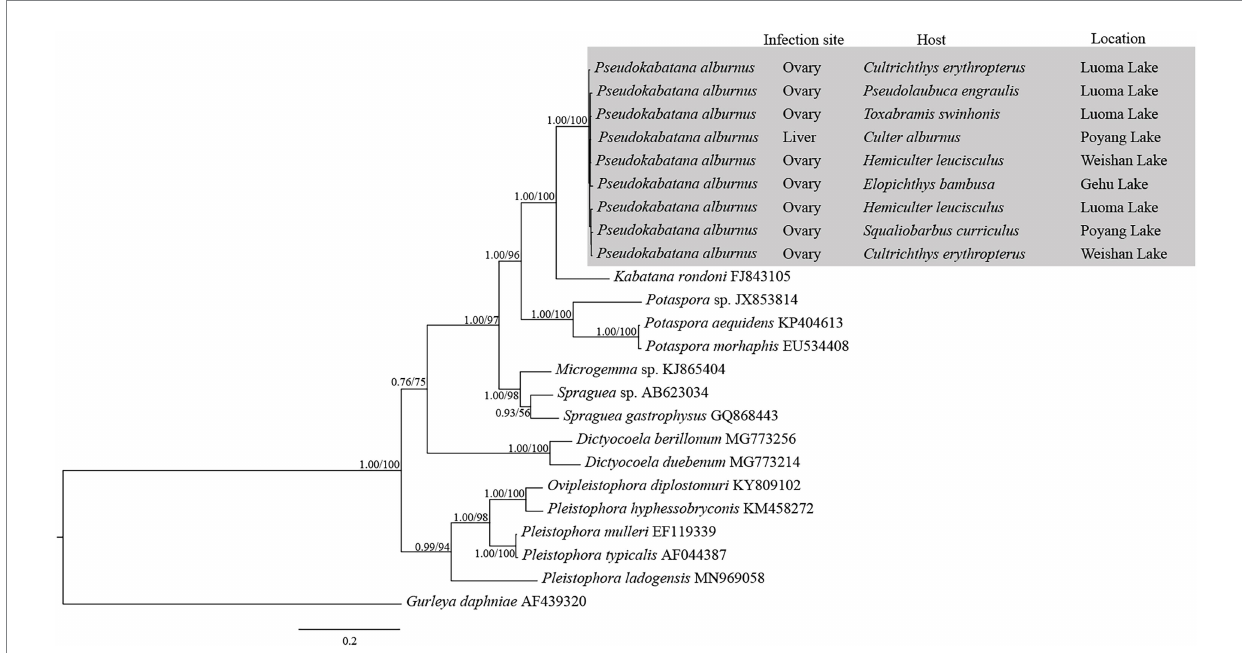
FIGURE 8 The rDNA unit (partial SSU + ITS + partial LSU)-based phylogenetic relationships between Pseudokabatana alburnus and the other aligned microsporidian species by Bayesian Inference (BI) method. The species names are followed by GenBank accession number. BI posterior probabilities were shown firstly, followed by ML support values on branch nodes. The infection site and host, as well as the geographical location of P. alburnus were presented.